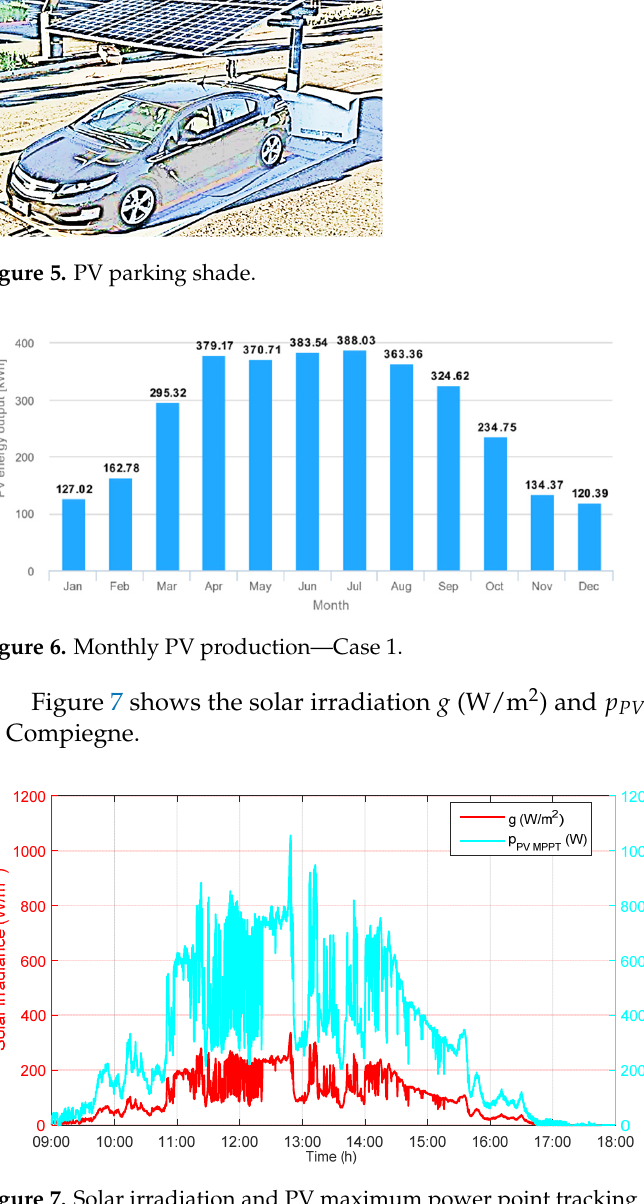
Figure 7. Solar irradiation and PV maximum power point tracking (MPPT) power—Case 1.